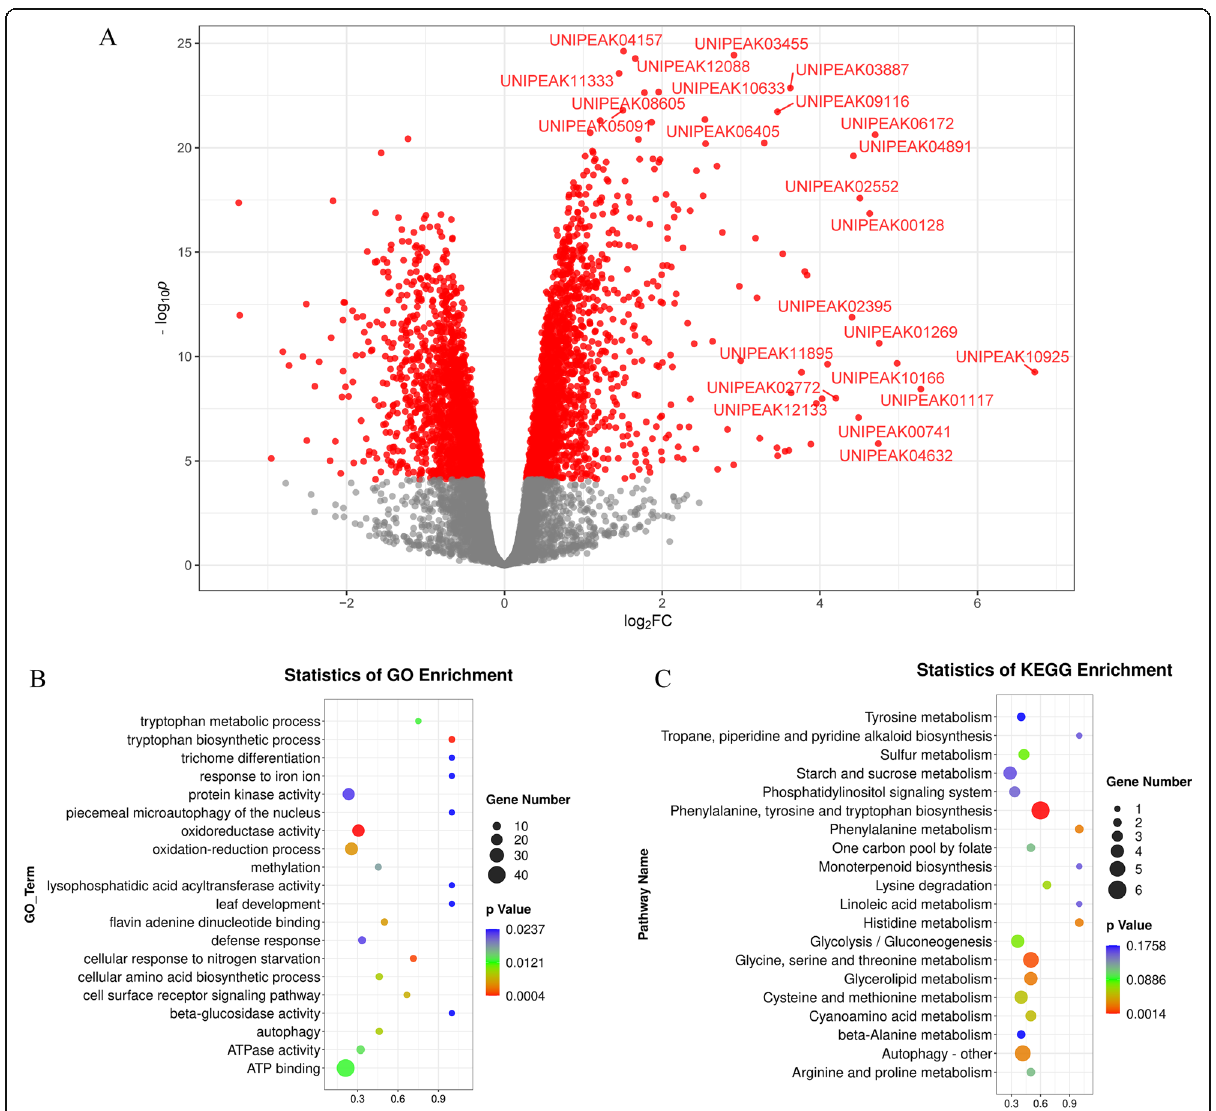
Fig. 4 Gene ontology and Kyoto Encyclopedia of Genes and Genomes analyses of coding genes containing differentially enriched m 6 A hcpeaks in cv. 9311_CK vs. cv. 9311_Cd. ( A ) Volcano plot showing logFC against statistical significance. Hcpeaks with FDR < 0.05 are coloured red with select points at the extremities of the plot labelled for easier visualisation (top 10 DE peaks or logFC < -4 or logFC > 4) ( B ) Major gene ontology terms were significantly enriched for these genes. ( C ) Major Kyoto Encyclopedia terms were significantly enriched for these